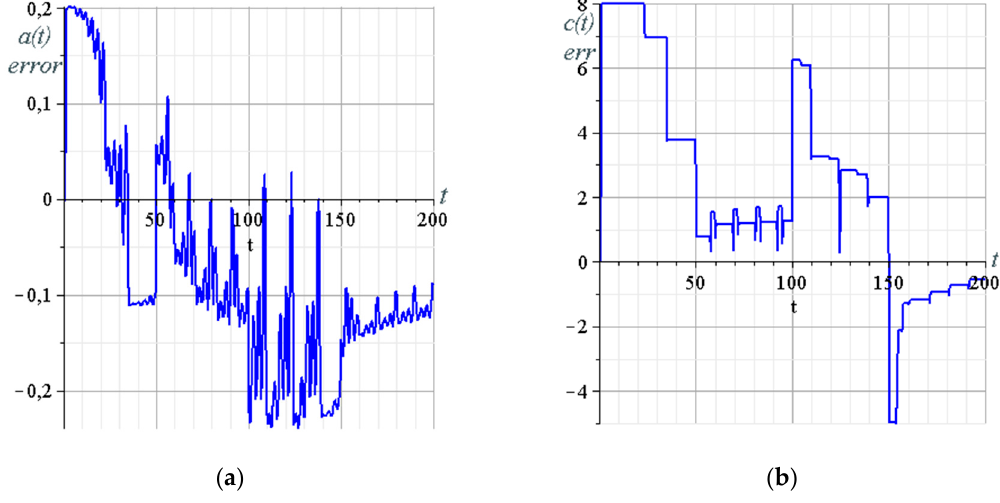
Figure 19. Transmitted signal LS method reconstruction error: ( a ) signal a reconstruction error; and ( b ) signal c reconstruction error.